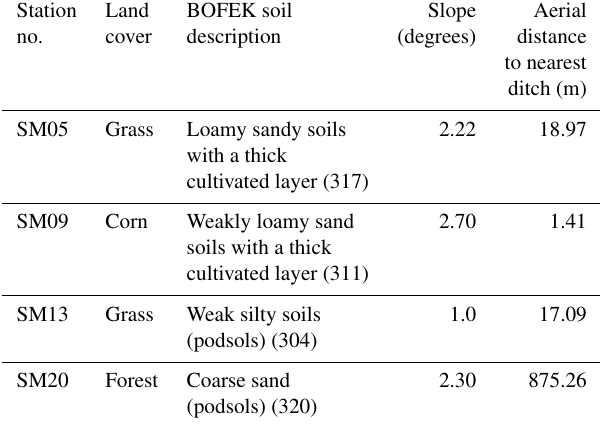
Table 1. Summary of land cover descriptions at each station cover- ing the period of 2014–2016. Soil descriptions and codes are based on BOFEK 2012 (Wosten et al., 2013). Both the slope and dis- tance to nearest ditch were determined from 5m resolution DEM. Datasets are from 2016 and were obtained from the publicly avail- able national topographic database of the Netherlands